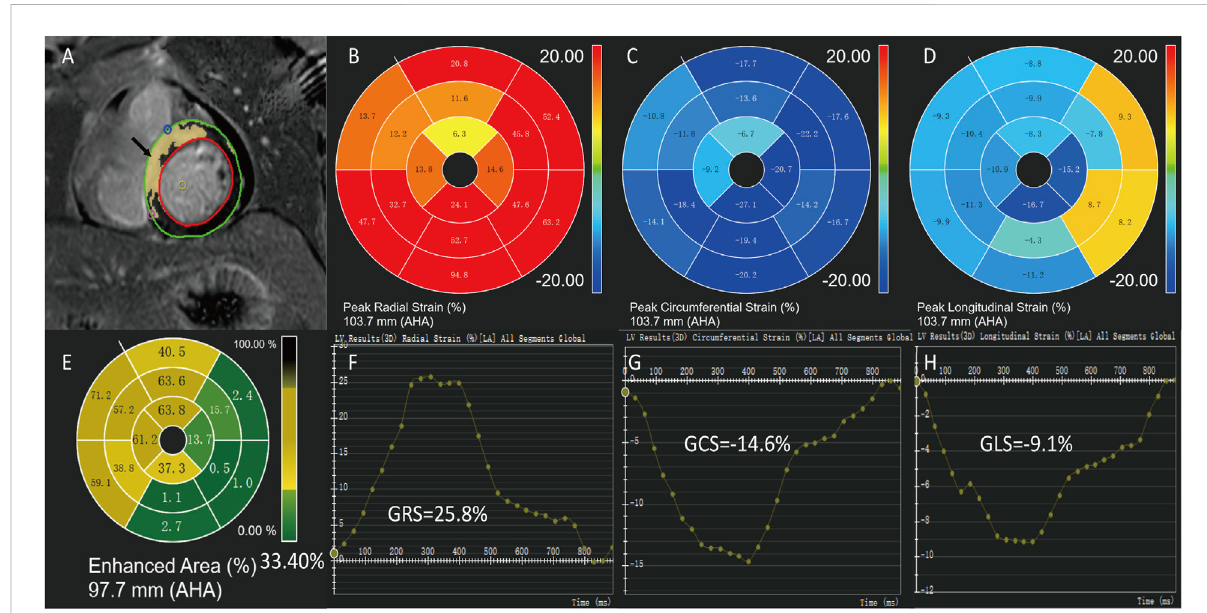
FIGURE 2 Measurement of cardiac magnetic resonance imaging. A 43-year-old male of ST-segment elevation myocardial infarction with preserved left ventricularejectionfraction.Epicardial(green)andendocardial(red)contours,LGEareasaremarkedinyellow (A,E) .Feature-trackingstrainvaluesof thesamepatientshowglobalradialstrain(GRS)=25.8% (B,F) ,globalcircumferentialstrain(GCS)=-14.6% (C,G) andgloballongitudinalstrain(GLS)= -9.1% (D,H) .